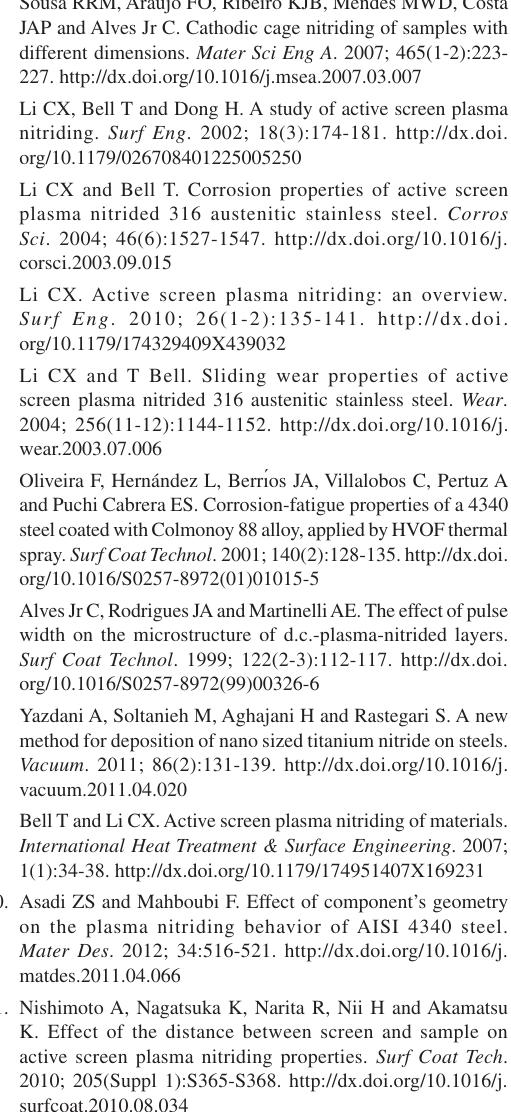
Figure 7. Micro hardness as a function of applied load of high carbon steel samples nitrided for different treatment times (1-4